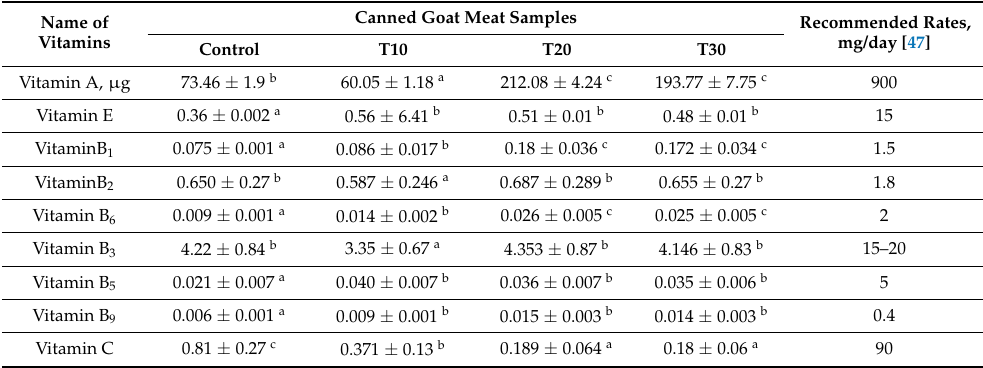
Table 4. Vitamin content of canned goat meat, mg/100